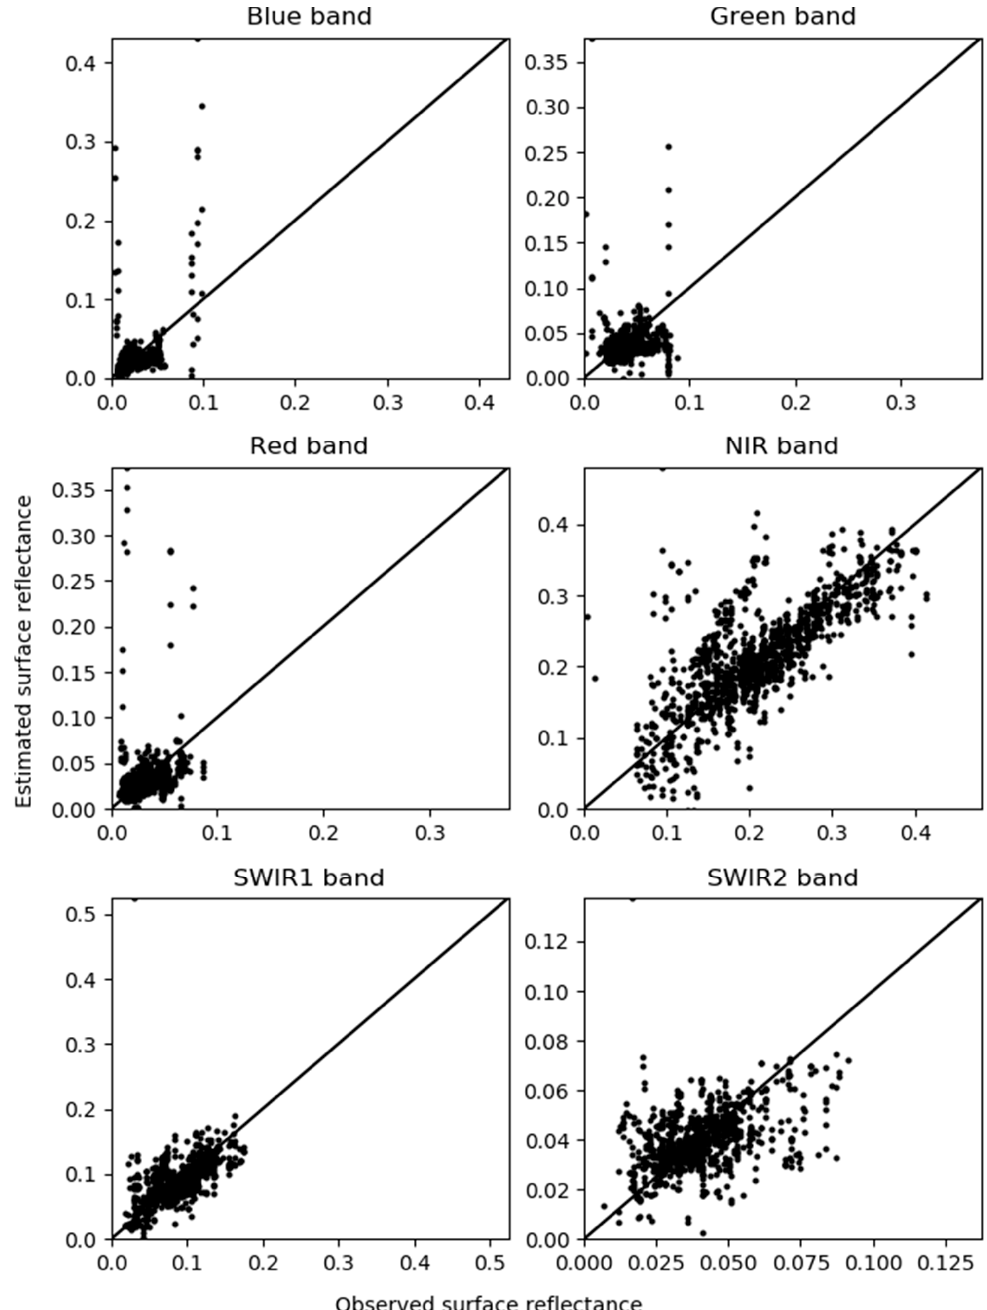
Figure 8. Scatterplots of the observed (x-axis) and the predicted reflectance (y-axis) for the blue, green, red, and near-infrared, shortwave infrared 1, and shortwave infrared 2 bands.